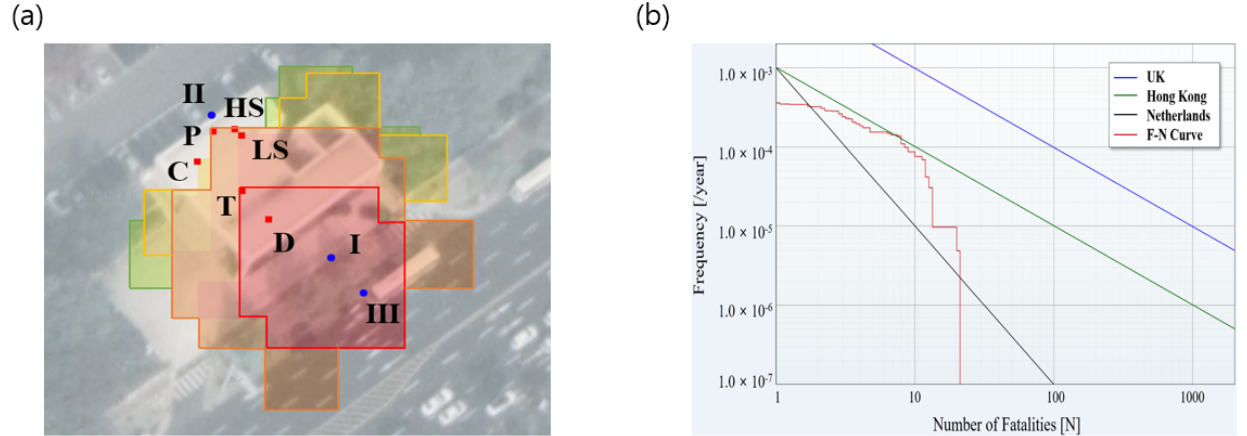
Figure 3. ( a ) Analysis of the contribution of societal risk posed by hydrogen refueling facilities and ( b ) F–N curve analysis according to the installation of hydrogen refueling station facilities in urban areas.